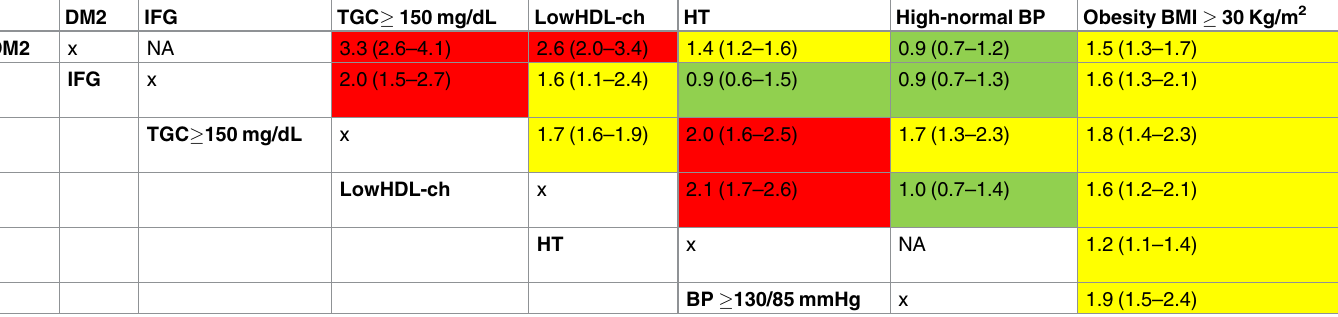
Table 5. Risk of the first episode of metabolic syndrome in relation to the occurrence of the first two components. Multivariate